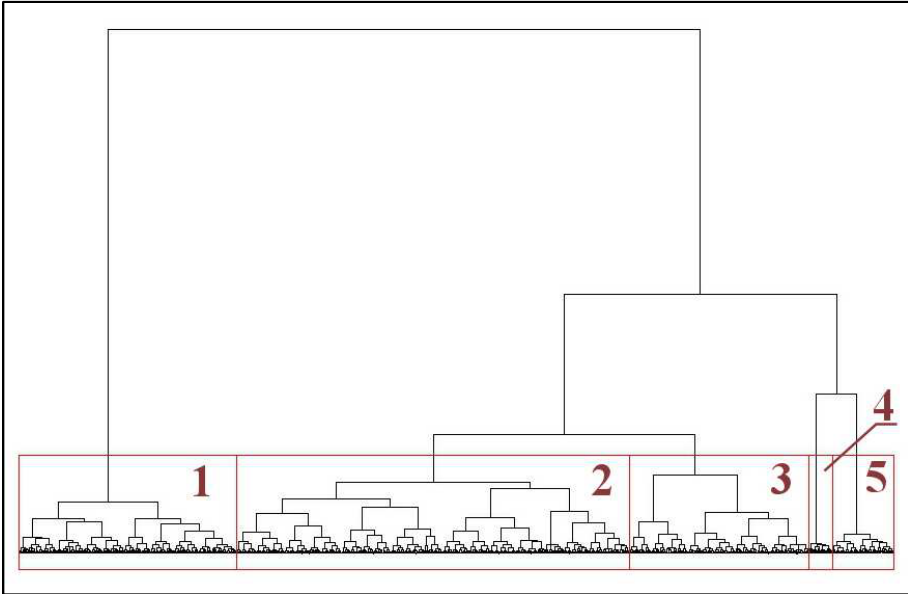
Figure 2 – Created dendrogram with 5